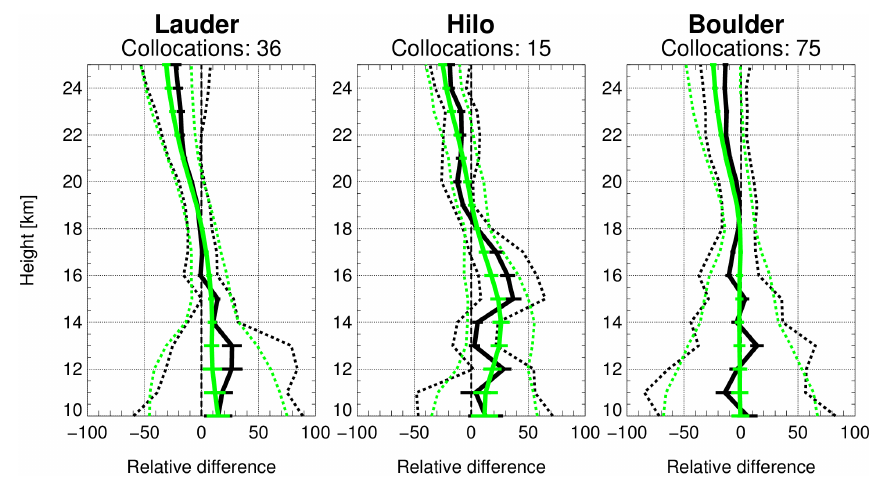
Figure 13. Same as right panel of Fig. 12, but for individual balloon stations. Left panel: Lauder (SH mid-latitudes), middle panel: Hilo (tropics), right panel: Boulder (NH mid-latitudes).